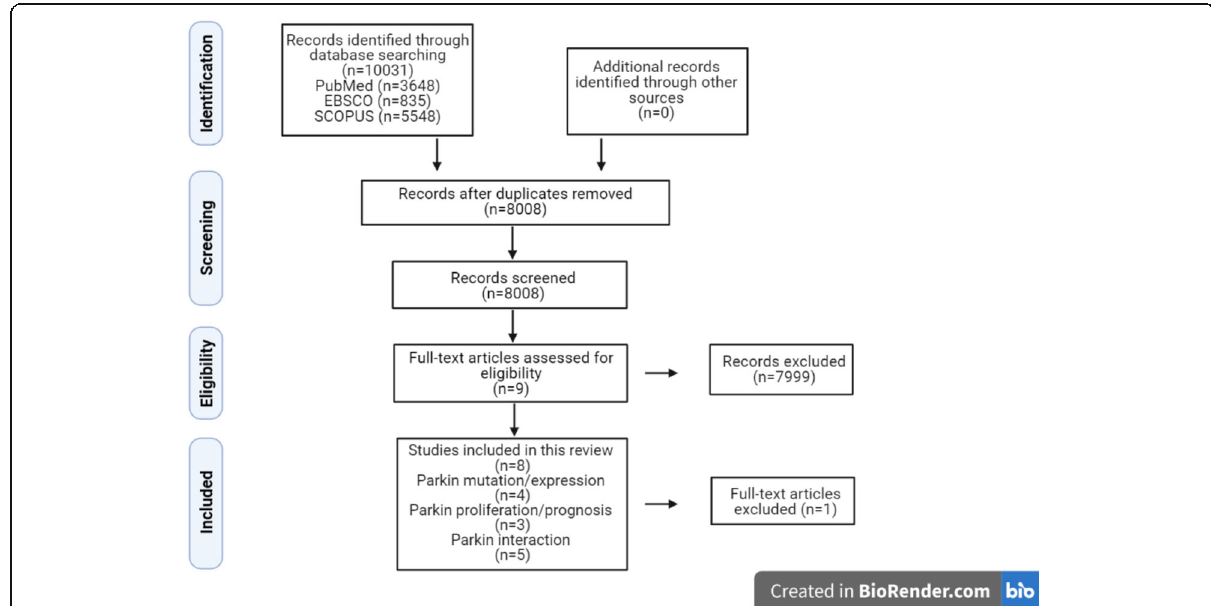
Fig. 1 PRISMA flow diagram, detailing the inclusion and exclusion criteria and the number of studies included and excluded at each step of the literature